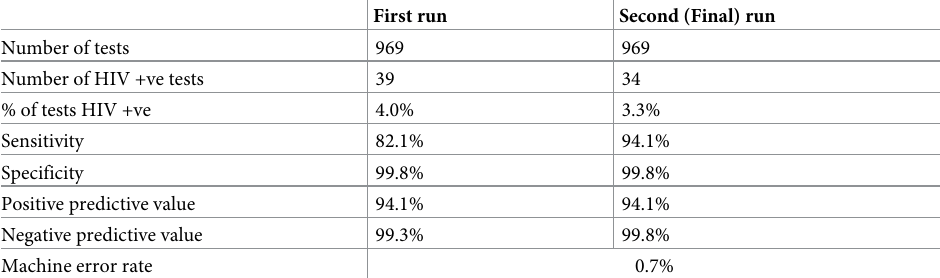
Table 2. Performance of Cepheid GeneXpert HIV-1 Qual (first and second runs) against Roche CAP/CTM HIV-1